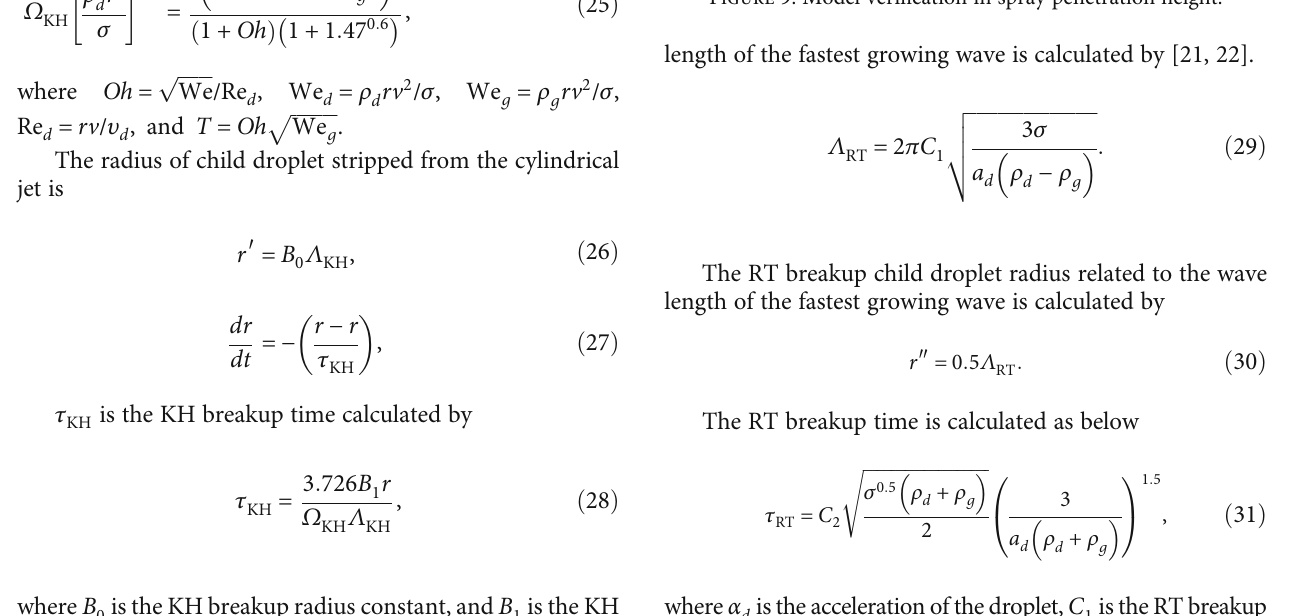
Figure 9: Model veri fi cation in spray penetration